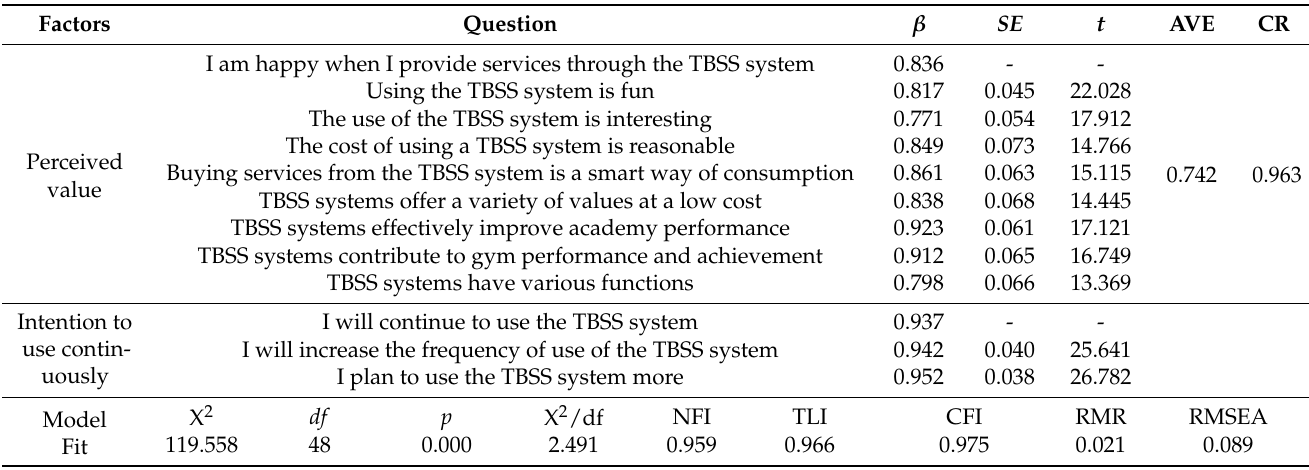
Table 3. Results of CFA on single-dimensional